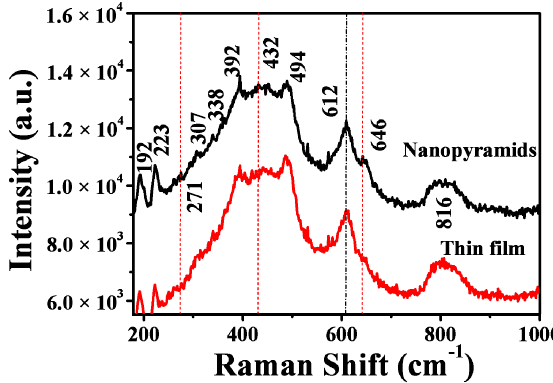
Figure 2. Room temperature Raman spectra of VO 2 nanofilms deposited on the silicon substrate before and after oxygen injection. The excitation power for the Raman spectra was fixed at 1 mW.